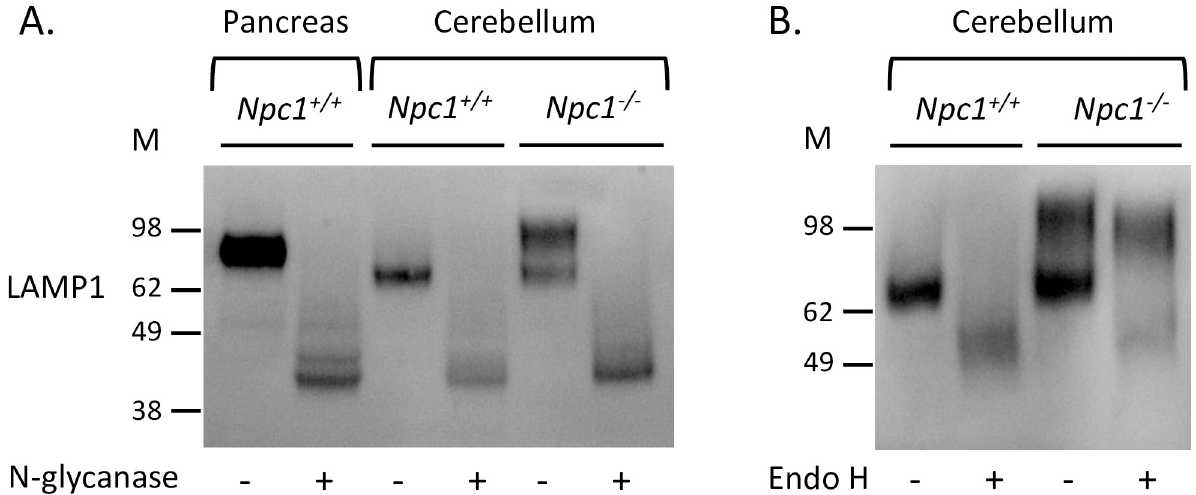
Fig 3. Higher molecular weight is due to LAMP1 hyperglycosylation. A. LAMP1 Western blot of 9-week Npc1 +/+ pancreas and cerebellum and Npc1 −/− cerebellum extract treated with (+) and without (-) N-glycanase. B. LAMP1 Western blot of 9-week Npc1 +/+ and Npc1 −/− cerebellum extract treated with (+) and without (-) Endo